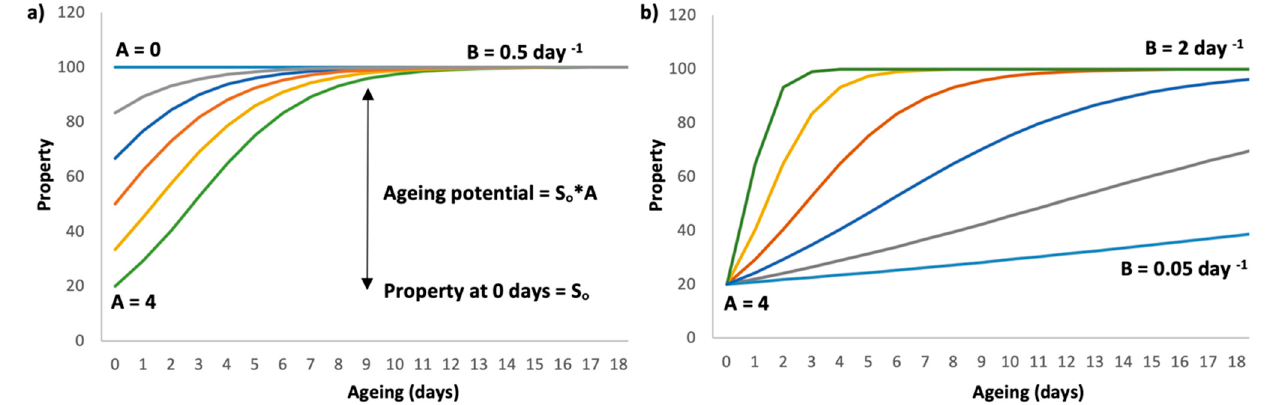
Figure 4. Representation of the logistic fitting for: ( a ) different ageing potentials, described by A and ( b ) different ageing rates, described with B. Note that the steady state, S ∞ , was chosen to have a constant value of 100 for all the graphs and that the time required to reach it changes with B, while S o varies with the value of A.